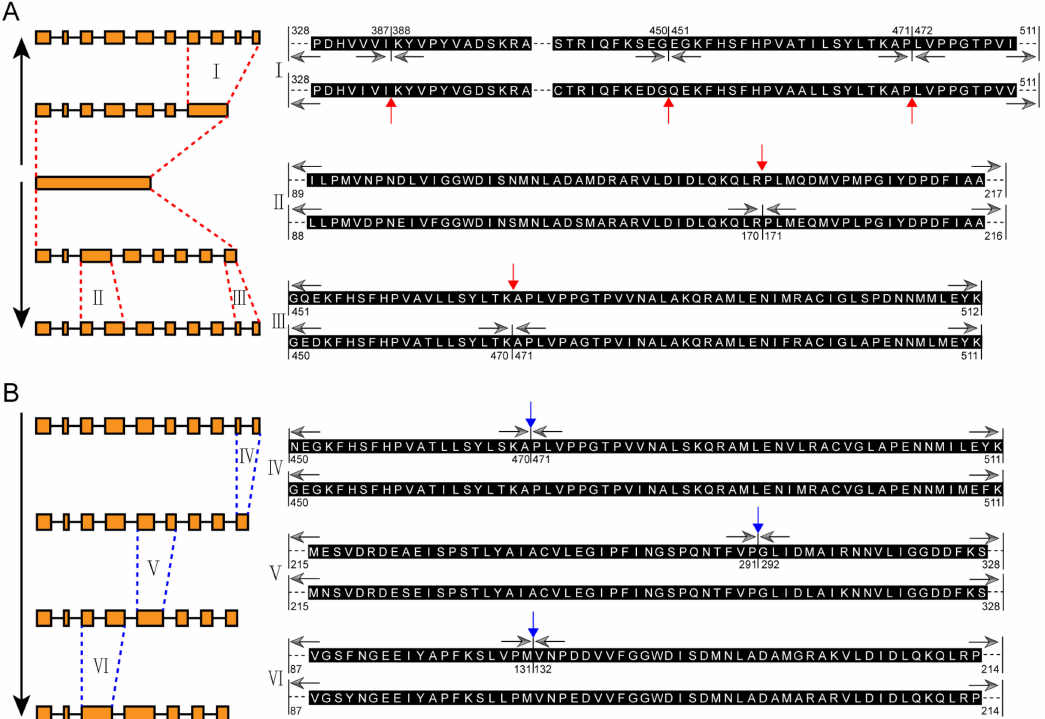
Figure 4. Illustration of the evolution model of MIPS exon-intron structures. ( A ) The evolution model of exon split events. MIPS possesses one entire exon in single cell algae. One evolution event has been recognized in Bryophytes plants, leading to a seven-exon PpMIPS2 (up-arrow) and an eight-exon PpMIPS1 (down-arrow). Then some of the exons have been split into more exons, forming the predominant exon-intron structure in higher plants (events I, II and III). The exon split sites are indicated by red arrows and amino acid numbers. ( B ) The evolution model of exon merge events in Brassicales plants. Three exon merge events have been identified, indicating there were three independent evolutionary events during the evolution of Brassicales plants. The exon-merge sites are indicated by blue